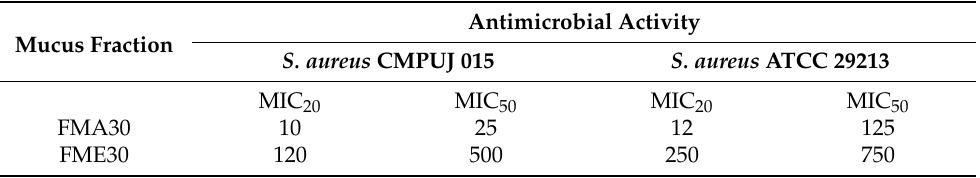
Table 2. Minimum inhibitory concentration 50 (MIC 50, µ g/mL) and sub-inhibitory concentrations